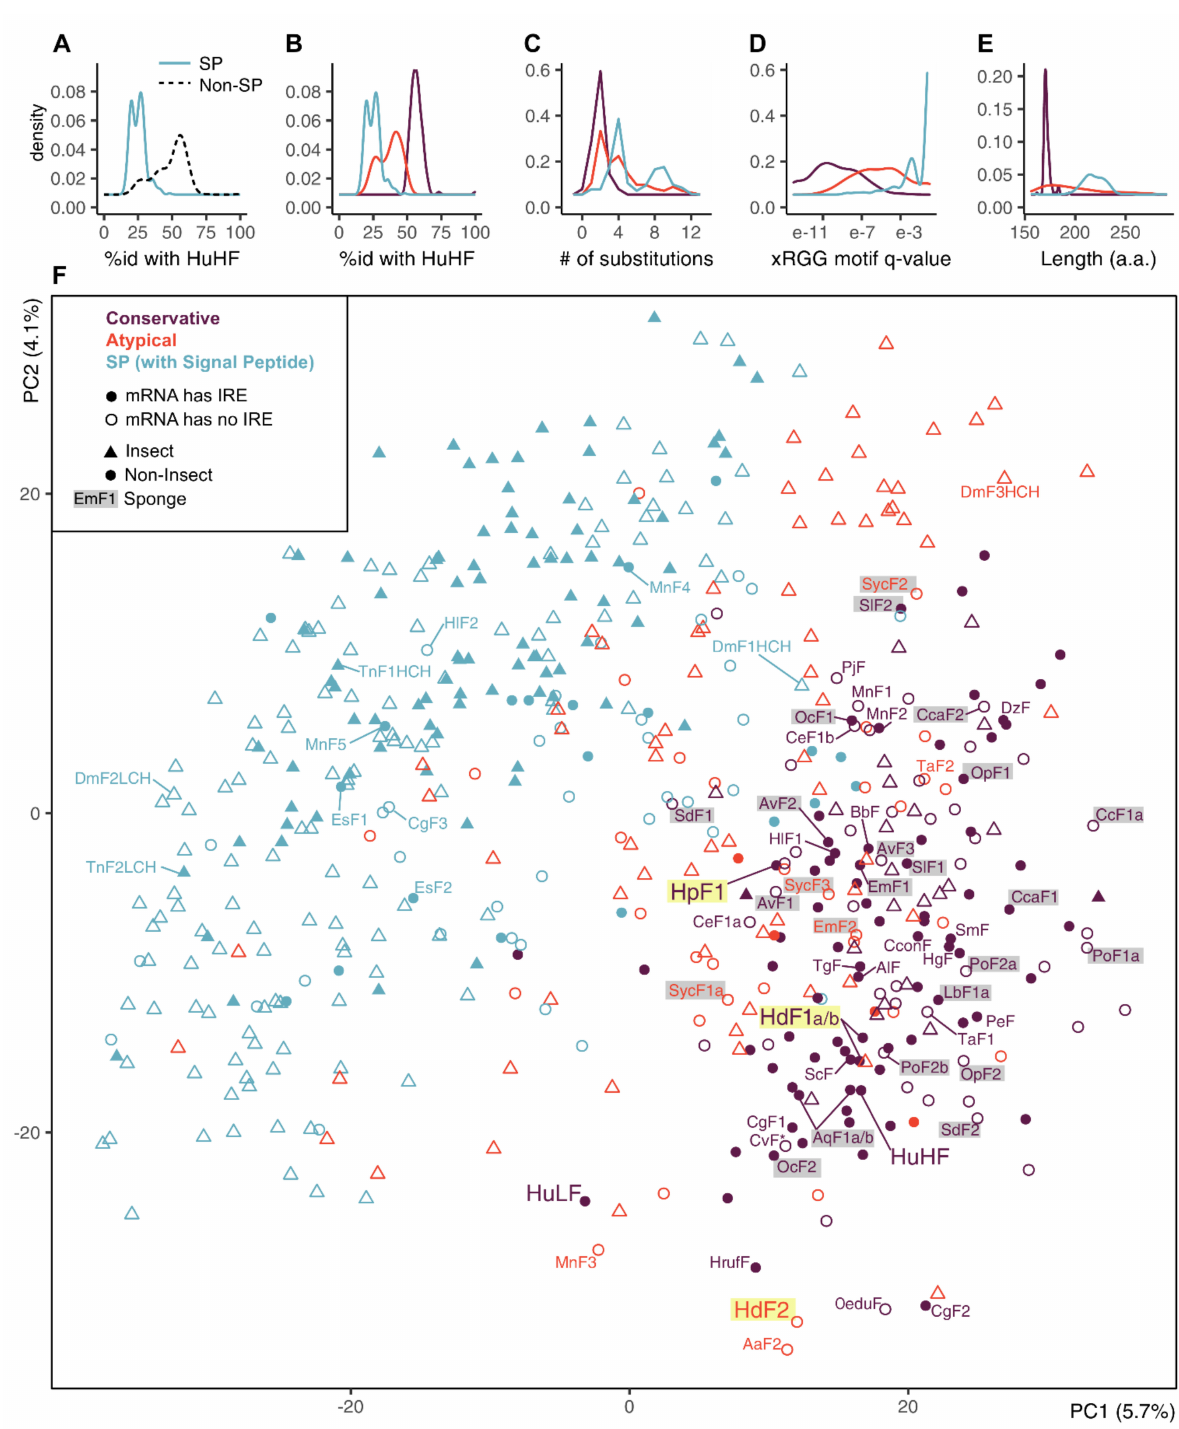
Figure 4. Principal component analysis (PCA) plot on a set of animal ferritins built using 474 sequence features selected by unsupervised algorithms. ( A , B ) Distribution of identity percentages with HuHF in ferritins of two classes of SP and SP-less ferritins and after dividing SP-less ferritins into conservative and atypical classes. ( C – E ) Distributions of the number of replacements in the three functional domains, the xRGG motif q-value, and protein sequence lengths in the ferritins of three classes. ( F ) PCA plot of 533 analyzed invertebrate and human ferritin sequences (Supplementary Table S1) built by selected feature subset (474 out of 6567 sequence features combined from top-100 features selected by five unsupervised feature selection algorithms, see Section 4, Supplementary Table S4) and showing prior class labels. Sponge ferritins are highlighted with grey, H. dujardini and H. panicea ferritins are highlighted with yellow. The large version of this plot with all the labels is shown in Supplementary Figure